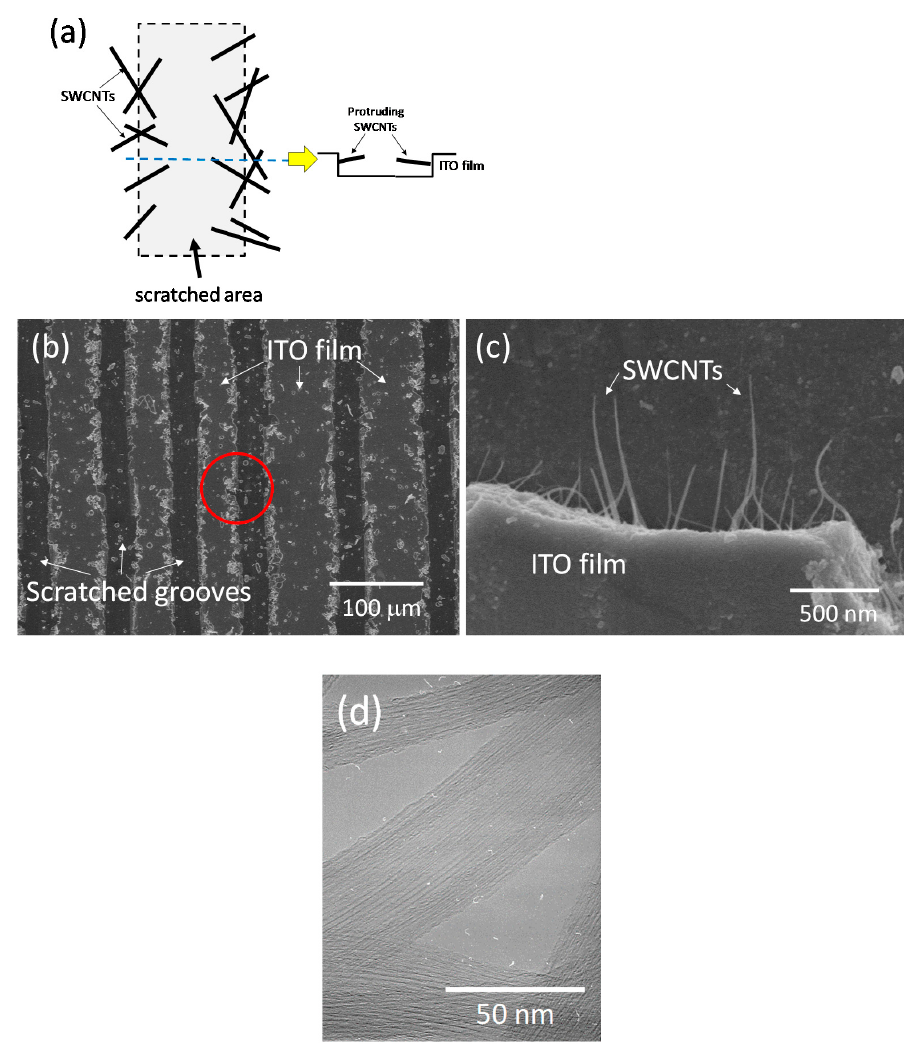
Figure 1. Tin-doped indium oxide (ITO) film images after field emission (FE) activation. ( a ) Schematic diagram of the scratched area and single-walled carbon nanotubes (SWCNTs) protruding from the ITO film; ( b ) Scanning electron microscope (SEM) overview after scratching the ITO film, including metallic SWCNTs to activate FE; and, ( c ) Enlarged SEM view of the metallic SWCNTs protruding from the ITO film; ( d ) Transmission electron microscope (TEM) overview of bundles of metallic highly crystalline SWCNTs that were used in the ITO film ( b , c ).